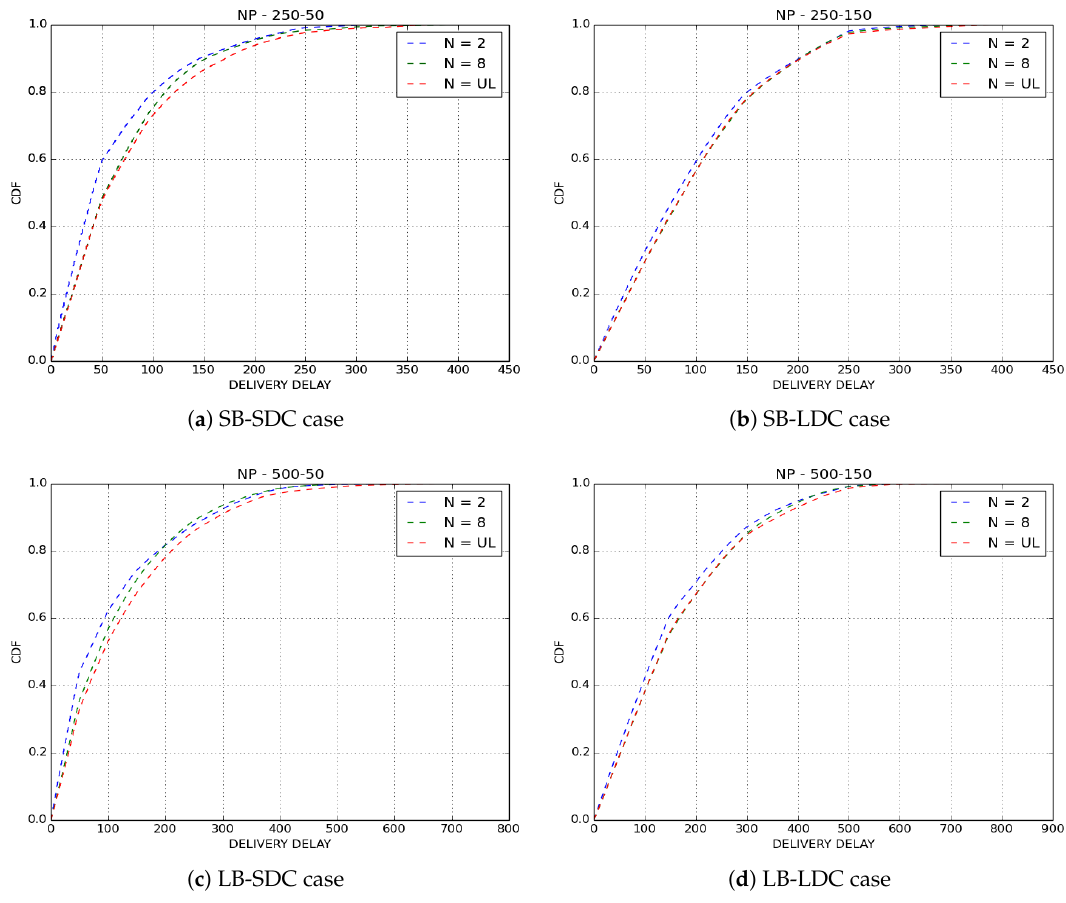
Figure 12. Delivery delay for NP buffer management